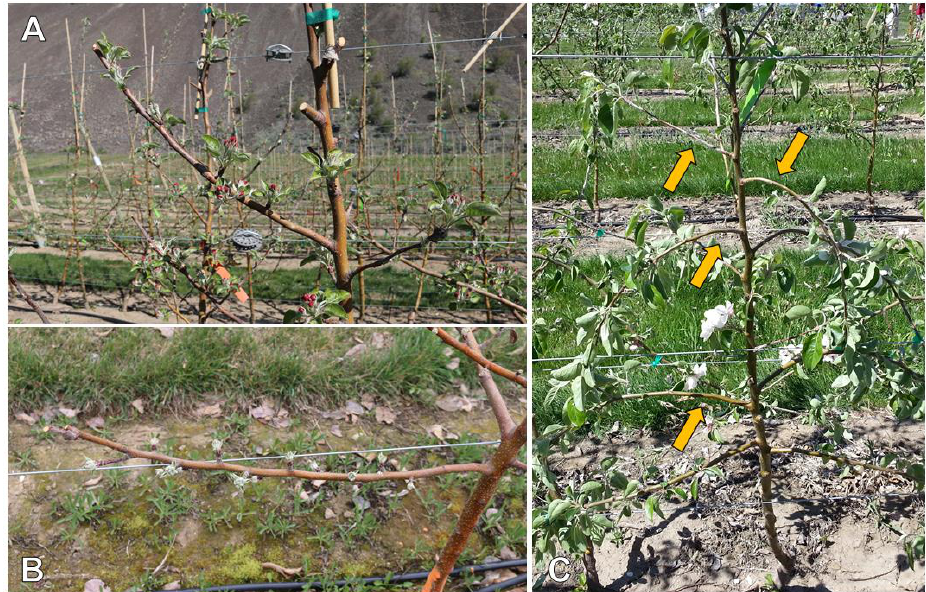
Figure 1. ( A ),( B ) Pictures depict the “click” pruning method of shortening one-year-old wood and heading shoots with crotch angles around 45-degrees. This helps inhibit terminal fruiting, which bends the branch below 90-degrees and exhausts it. The “click” pruning in ( A ) and ( B ) also demonstrate the reduction of “blind wood” on the branches with a high incidence of flower buds across the totality of the branches. Whereas, the “bending” method ( C ) demonstrates the onset of “blind wood” (orange arrows) toward the basal portion of the shoots. Note that without the “click” pruning in ( C ), only the terminal tip flowers are predominantly present, as little lateral bud swelling has been